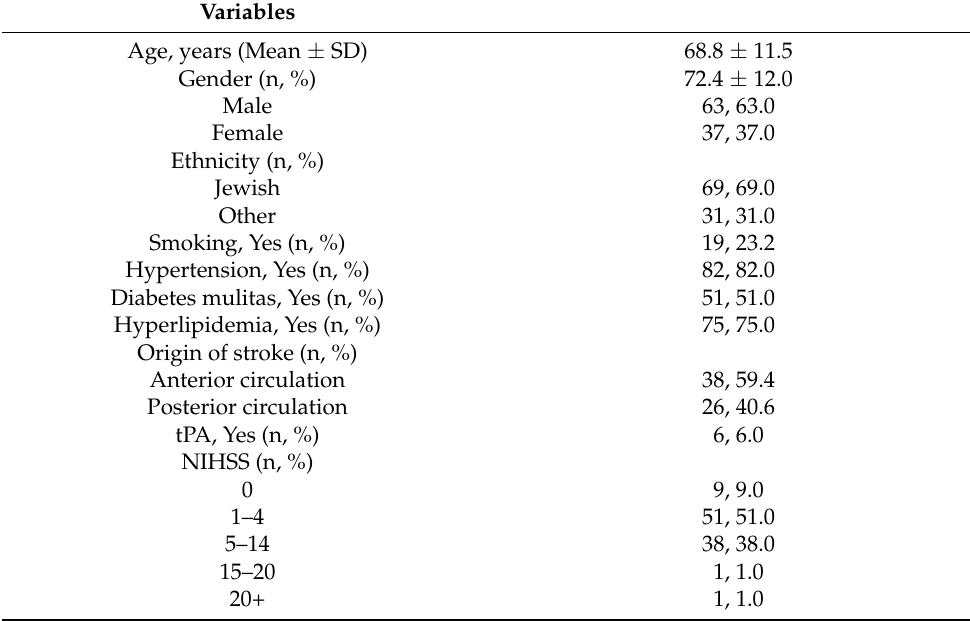
Table 1. Characteristics of the study patients.